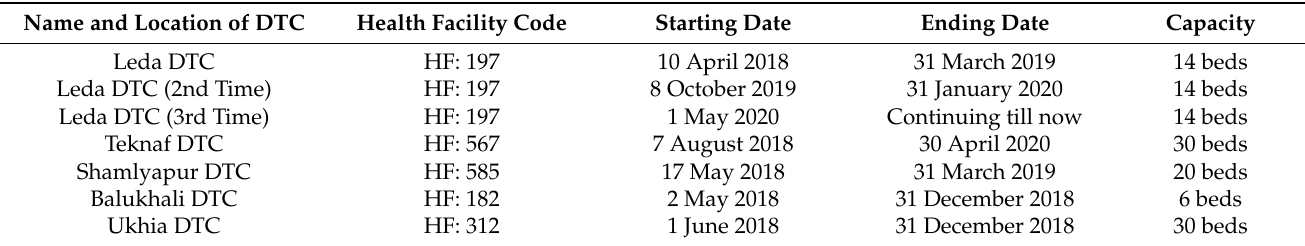
Table 1. Description and capacities of the